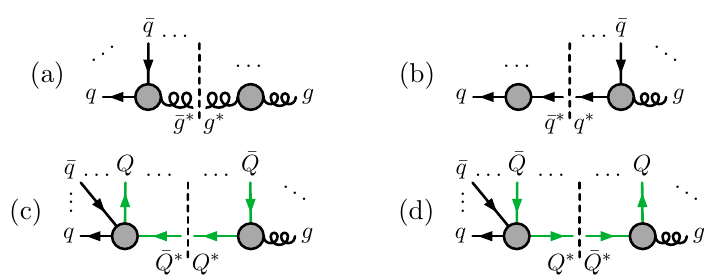
Figure 2 . Factorisation channels of qg -basis colour-ordered